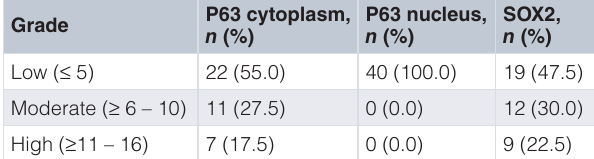
Table 2. Immunoreactivity score of P63 and SOX2 in